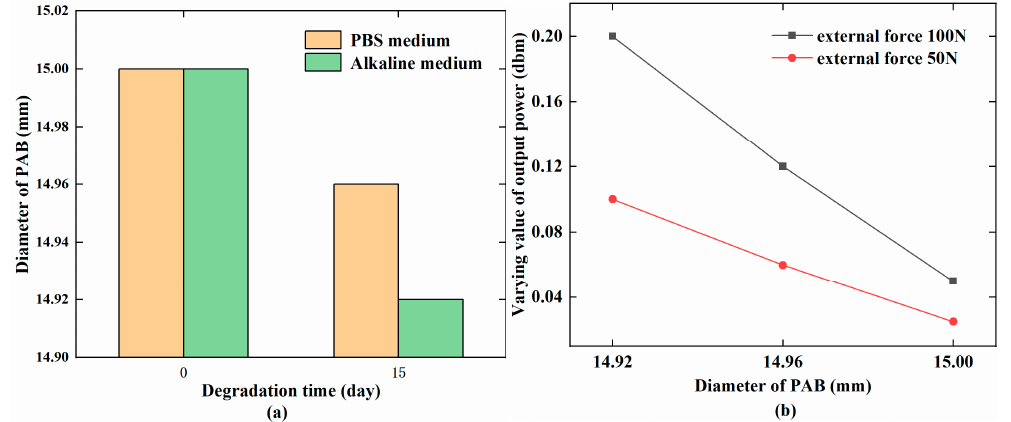
Figure 10. ( a ) Changes in the PAB diameter (mm) with the degradation time (days); ( b ) Relationship between the PAB diameter (mm) and varying value of the output power (dbm).